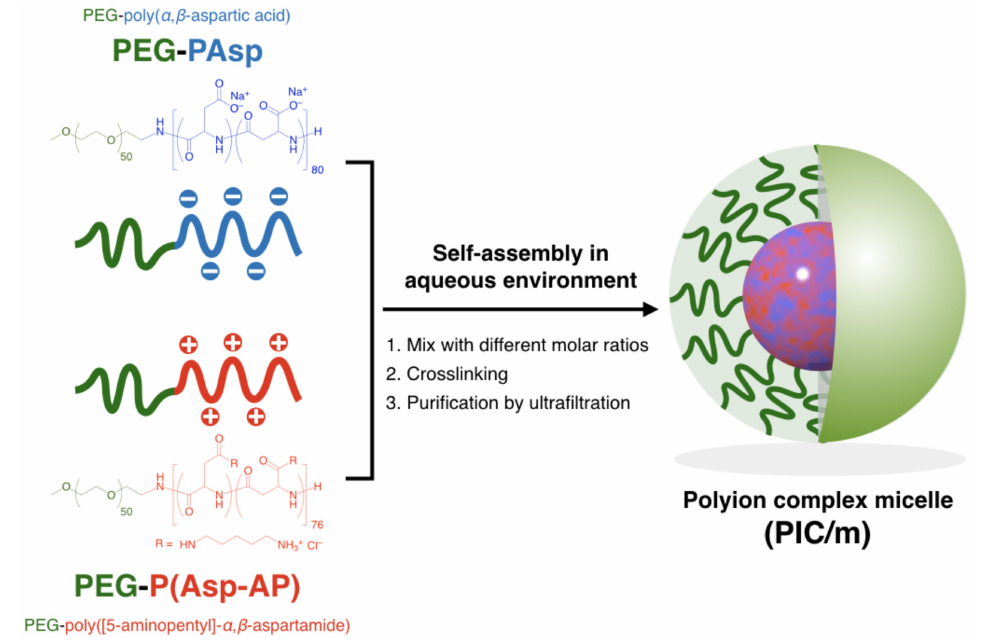
Scheme 1. Scheme of polyion complex micelles (PIC/m) preparation via the assembly of oppositely charged block copolymers with different mixing molar ratios of C/A.